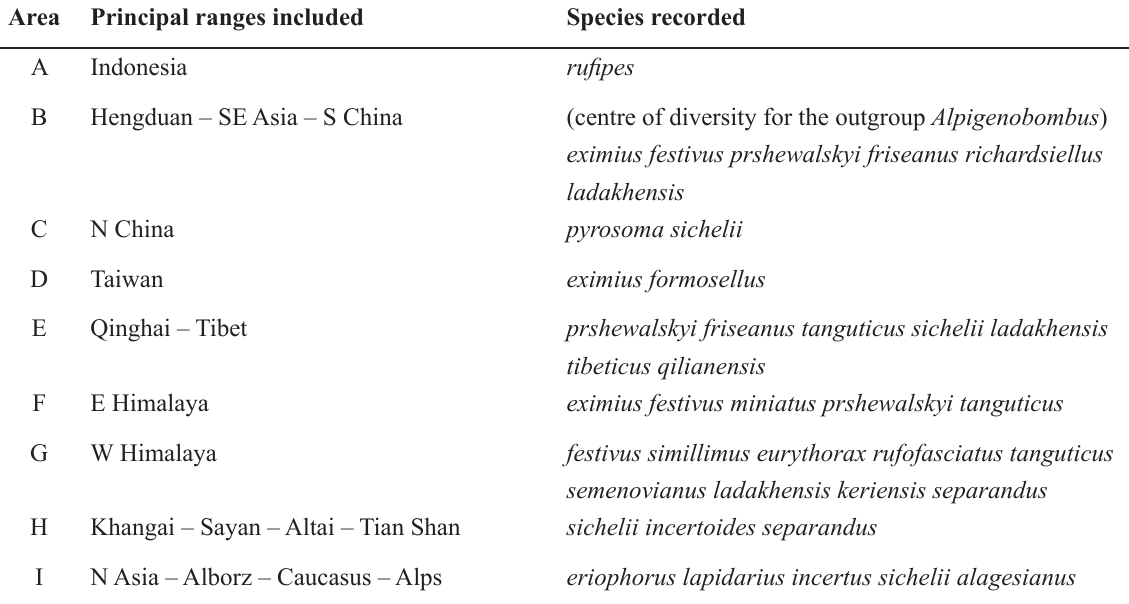
Table 5. Principal areas of endemic distribution identified for their combinations of bumblebee species of the subgenus Melanobombus von Dalla Torre,